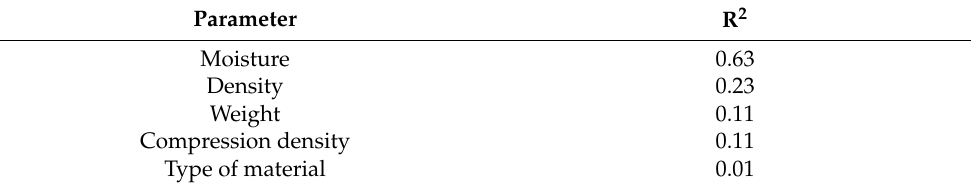
Table 3. Coefficient of determination (R 2 ) relating different variables and voltage measurements.